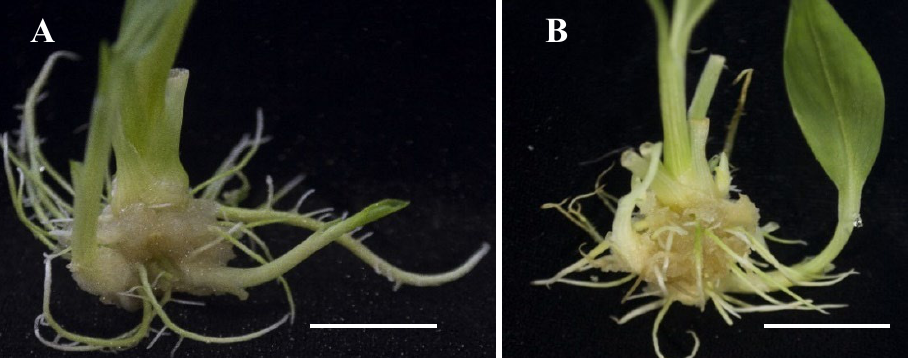
Figure 2. Calli induced around microrhizomes on MS medium supplemented with 4 mg/L (A)